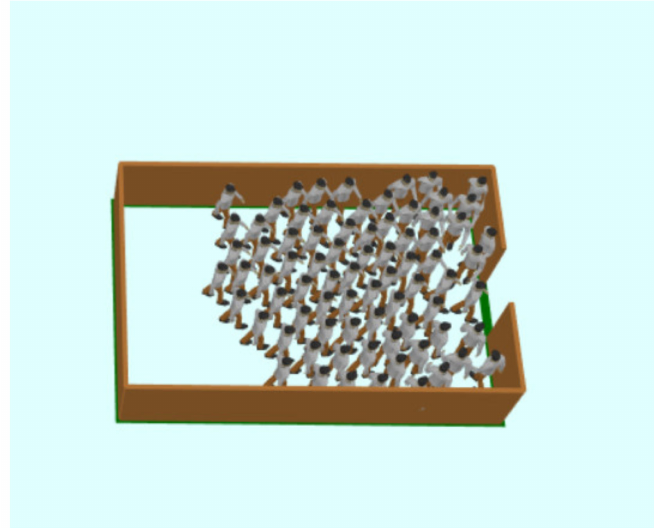
Figure A4. The scenario of test 4. Test 5: Response